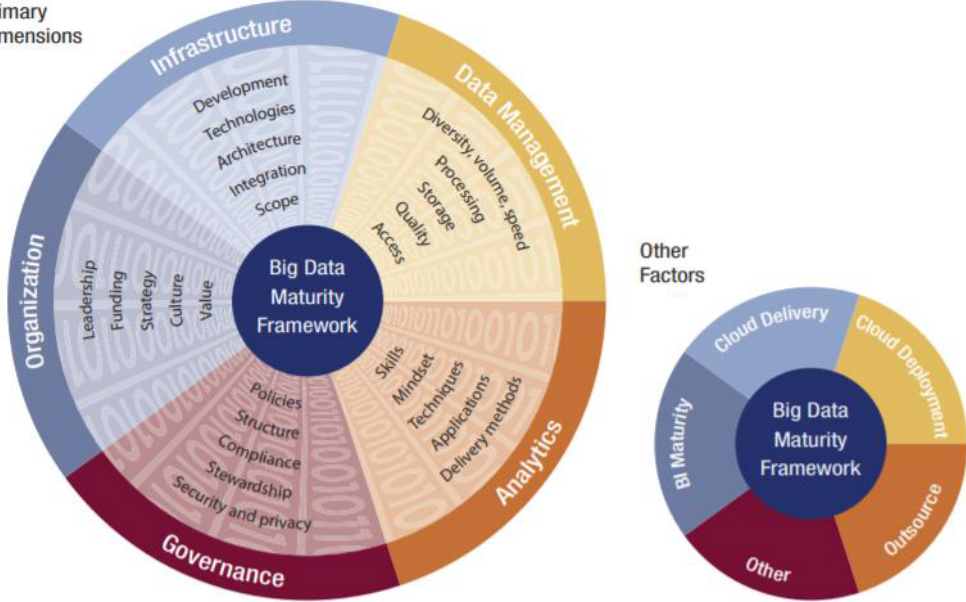
Fig. 4 Scores are supported 5 primary dimensions of big data maturity, and many alternative factors. (Source: TDWI Maturity Model) After completing data retrieval to the respondent, it will be mapped on the assessment score that refers to each dimension in the TDWI Maturity Model. The score table for each dimension is shown in table